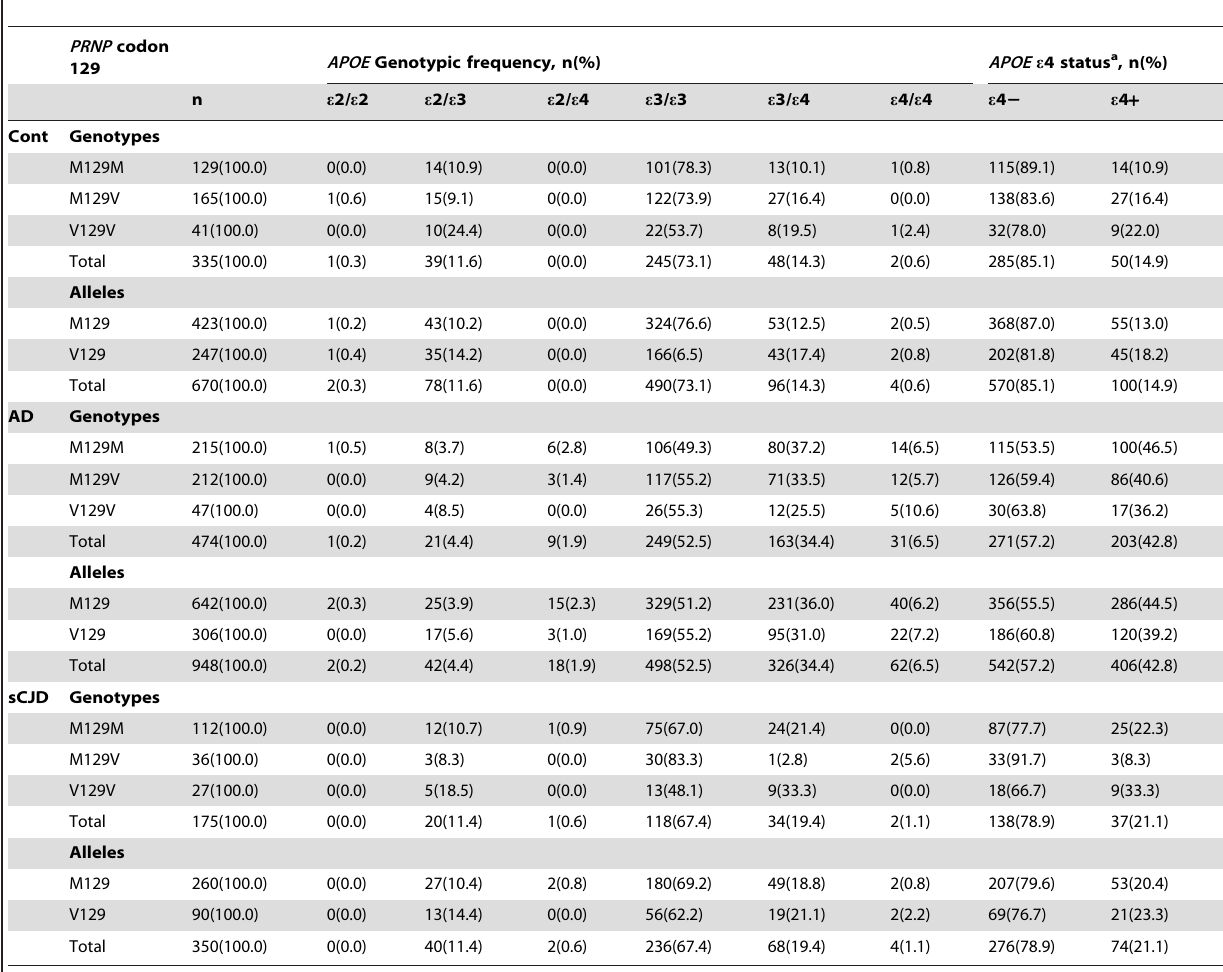
Table 1. APOE and PRNP codon 129 genotypic and allelic frequencies in control subjects (Cont) and patients (AD, sCJD).